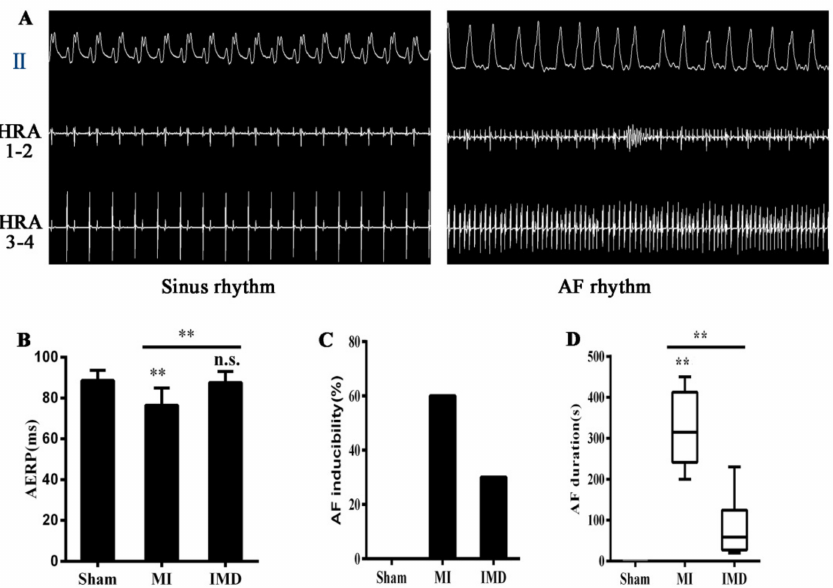
Figure 2. Characteristics of cardiac electrophysiology in rats. ( A ) Electrocardiogram of SR and AF. Right-atrial electrograms (HRA1-2 and HRA3-4) demonstrate rapid irregular atrial activations with varying electrogram morphology. Note that different atrial electrical activation patterns were recorded from the high right atrium (HRA1-2) and lower right atrium (RA3-4) during sinus rhythm and atrial fibrillation in rats. ( B ) Changes of AERP in rats. IMD1-53 improved AERP after the MI operation. ( C ) Bar graphs indicate the AF inducibility. IMD1-53 inhibited AF inducibility compared to the MI group. ( D ) Bar graphs indicate the AF duration. IMD1-53 decreased AF episode duration. Data in bar graphs are means ± SD, except the bar graph of figure ( D ), which presents the median and IQR (25–75%), n = 10. AF, atrial fibrillation. HRA, high right atrium; RA, right atrium. ** p <